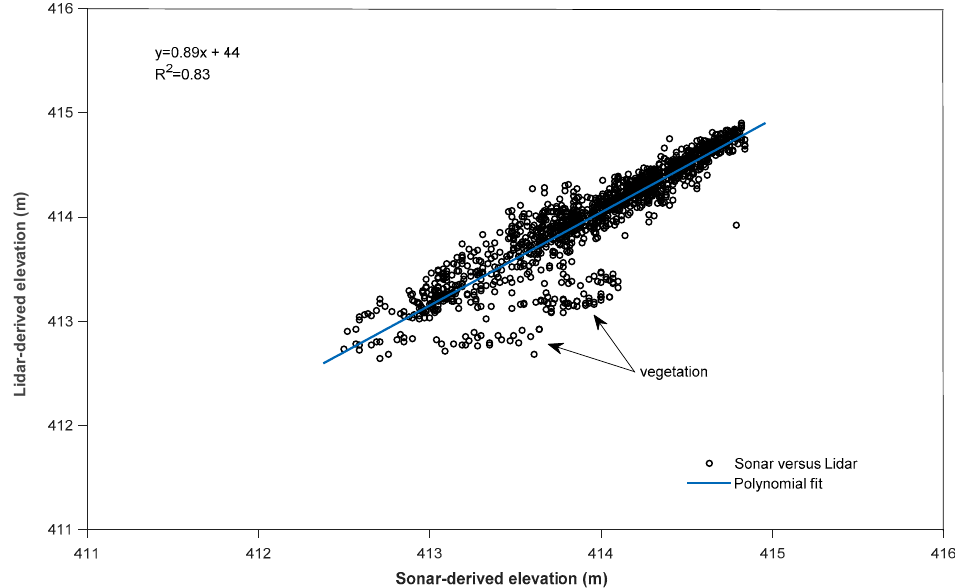
Figure 17. Basin 8 Lidar-derived elevation versus sonar-derived elevation—moderate amounts of submerged vegetation in water column.